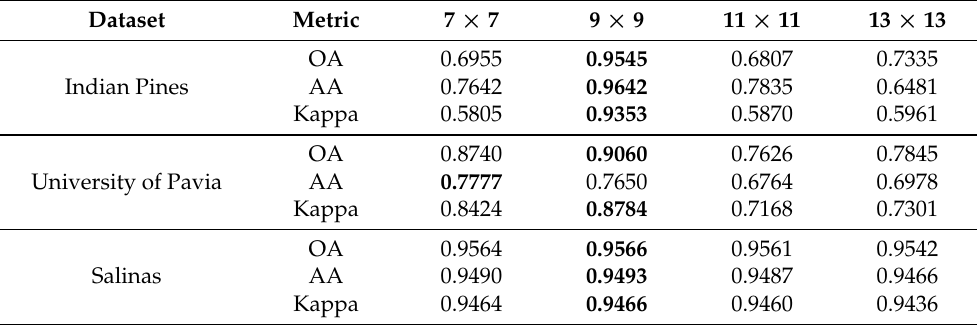
Table 7. Accuracy with different input patch sizes. The best value in a row is